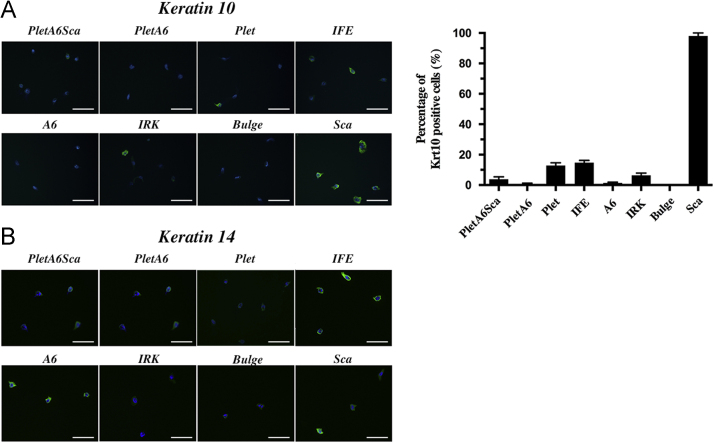
Krt10 and Krt14 immunofluorescence staining of the different epidermal populations. Freshly isolated keratinocytes were stained with antibodies against Itgα6, CD34, Sca-1 and Plet-1. Using flow cytometry, the different keratinocyte populations PletA6Sca, PletA6, Plet, IFE, A6, IRK, Bulge and Sca were sorted on slides and cytospun at 200g for 5 min. Cells were fixated and stained with either anti-Krt10 (A) or anti-Krt14 (B) primary antibodies with Alexa Fluor 488-conjugated secondary antibody. Using fluorescence microscopy, the numbers of green positive cells were visualized for each population. (A) Sca shows almost 100% of Krt10 positive cells, while IFE and Plet approximately consist of 15–20% Krt10-expressing cells. A summary graph of Krt10 positive cells is shown to the right. Error bars represent SEM (n=3). (B) With all keratinocytes having levels of the Krt14 protein, IFE and A6 show the highest Krt14-intensities of all the populations. Scale bar: 50 μm.